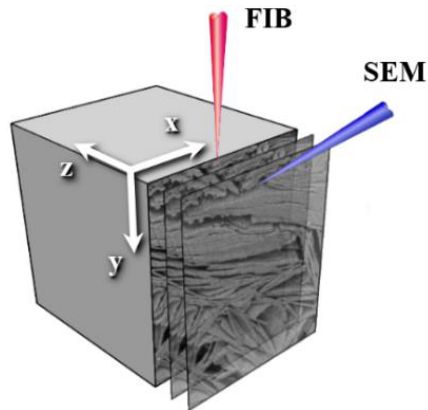
Figure 1. A scheme of Focused Ion Beam Scanning Electron Microscopy (FIB-SEM) tomography.